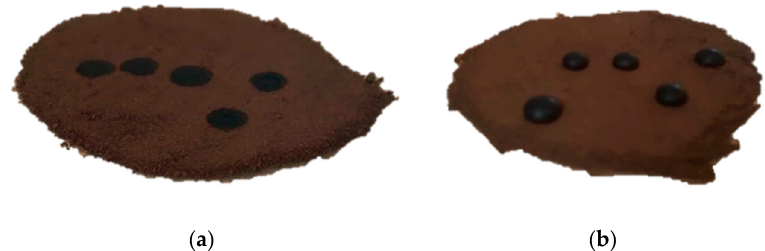
Figure 10. Type of hydrophobic properties of torrefied biomass: ( a ) hydrophilic (105°C); ( b ) extremely hydrophobic (300 °C).